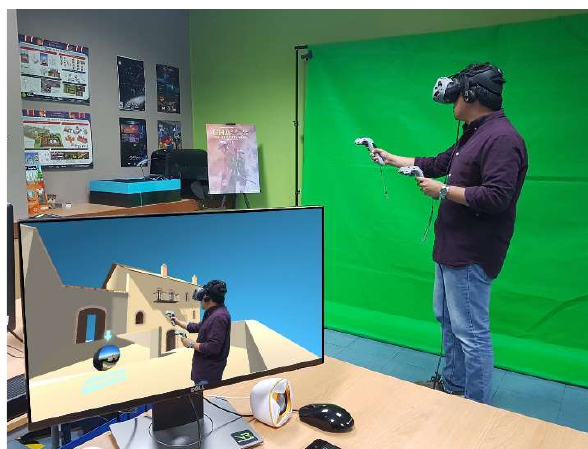
Fig. 14. Immersive navigation of the VR model